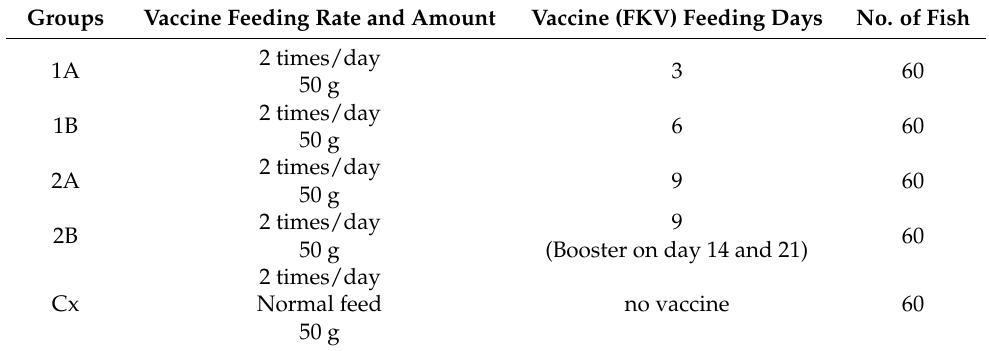
Table 1. Design of feeding trial (treatment groups, vaccine feeding period) in the Red hybrid tilapia. Groups Vaccine Feeding Rate and Amount Vaccine (FKV) Feeding Days No. of